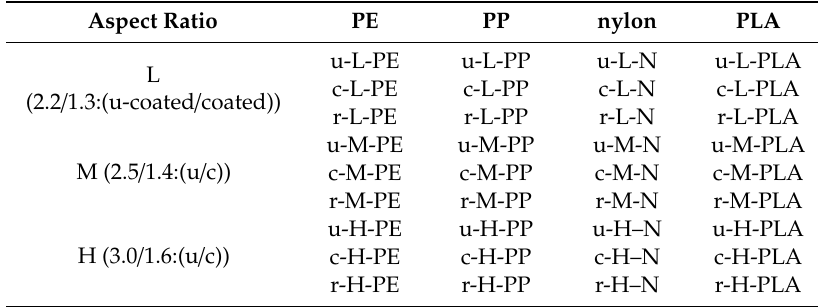
Table 1. Definition of samples based on the coating status, aspect ratio and kind of polymer used. Coating status (u—uncoated; c—coated; r—coated formulation removed); Aspect ratio of u-MNs and c-MNS (L—low 2.2 / 1.3 (u / c); M—medium 2.5 / 1.4 (u / c); H—high 3.0 / 1.6 (u / c)), Polymer